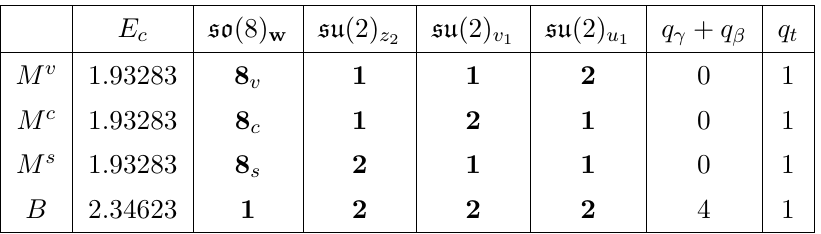
Table 10. Higgs branch operators of the T A SCFT that appear at the order τ 2 of the